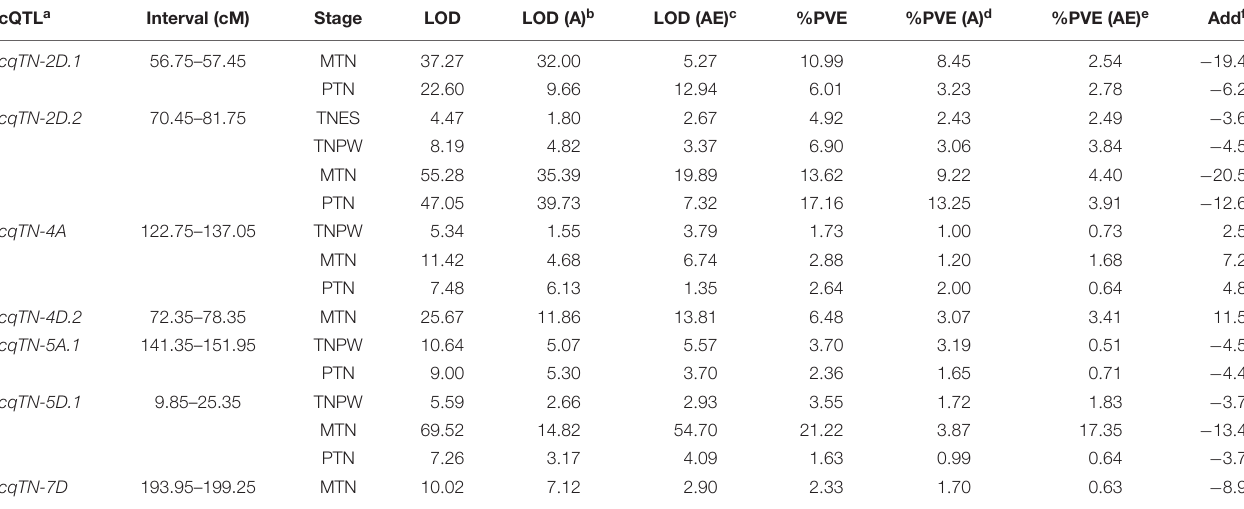
TABLE 4 | Combined QTL analysis for stable QTL.